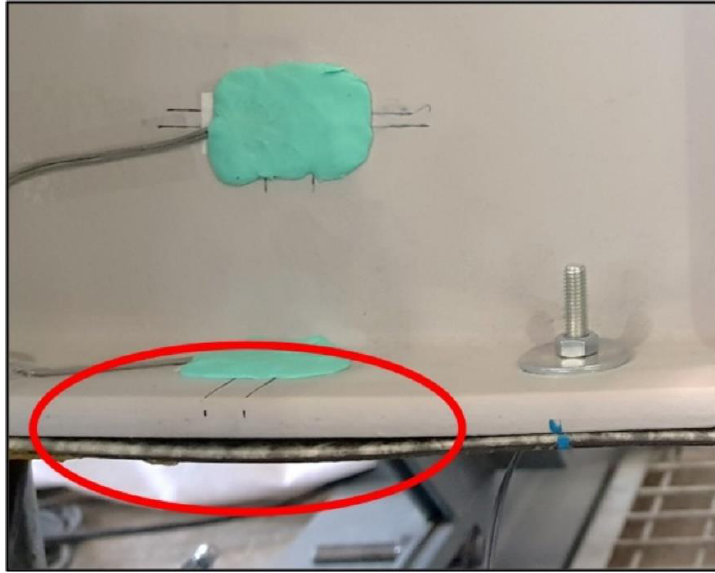
Figure 10. Sagging of the HFRP strip in 1620-S-150 beam.